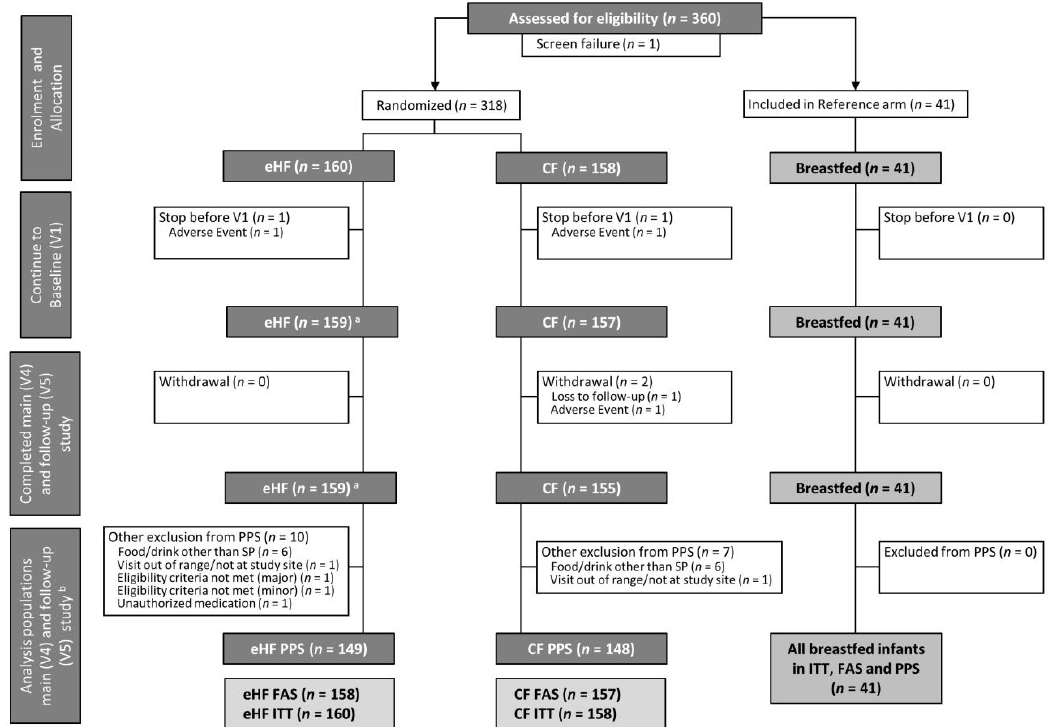
Figure 1. Flow chart of subject enrolment and distribution into formula-fed groups and breastfed